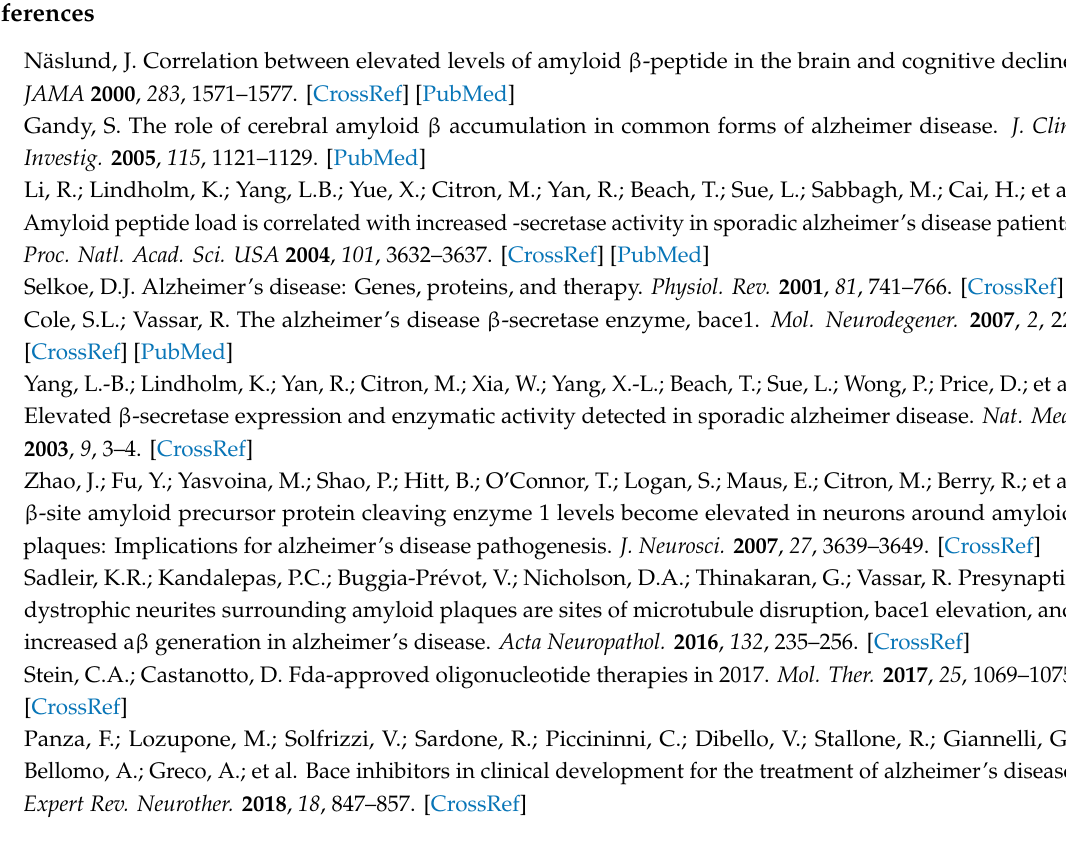
Figure S1: The RT-PCR products after treatment with AO1, AO2, AO3, AO4, AO5, AO6, AO7, and AO8 is shown here. Figure S2: The RT-PCR products after treatment with AO9, AO10, AO11, AO12, AO13, AO14, AO15, AO16, AO17, AO18, AO19, AO20, and AO21 is shown here. Figure S3: The RT-PCR products after treatment with AO2, AO6, AO12, and AO13 is shown here. Figure S4: The RT-PCR products after treatment with AO2, AO6, AO12, and AO13 is shown here. Figure S5: The RT-PCR products after treatment with AO2-PMO. Figure S6: The RT-PCR products after AO2 treatment amplified using di ff erent primer sets Figure S7: The western blot membranes after AO2 treatment incubated with anti-BACE1 antibody (top membrane) and anti-GAPDH antibody (bottom membrane). Table S1: The seeding density of HEK293 cells used for di ff erent assays., Table S2: The primer sets used to amplify BACE1 transcript., Table S3: The primer sets used to amplify GAPDH transcript., Table S4: The PCR conditions for each primer set. Table S5: The HPLC analysis of the most e ffi cient AOs (AO2, AO5, AO6, AO8, AO12, and